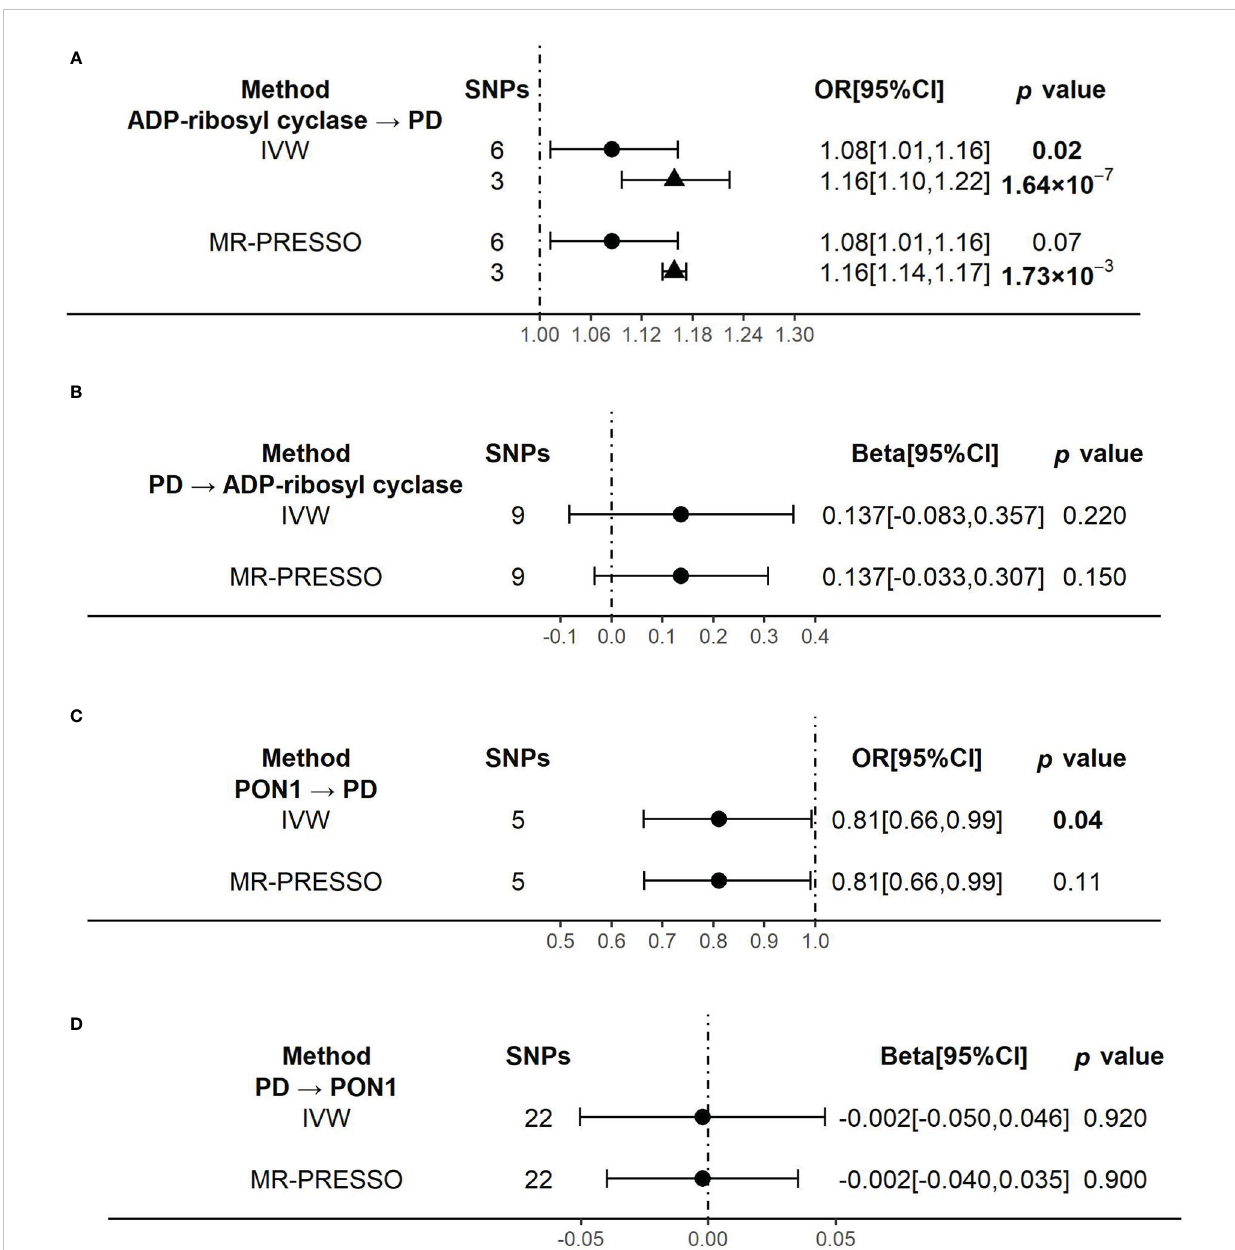
FIGURE 3 The results of the causal effects between ADP-ribosyl cyclase, PON1 and Parkinson ’ s disease by Mendelian Randomization analysis (A) The causal effect of ADP-ribosyl cyclase on PD. (B) The causal effect of PD on ADP-ribosyl cyclase. (C) The causal effect of PON1 on PD. (D) The causal effect of PD on PON1.. 95% con fi dence interval, 95% CI; inverse-variance weighted, IVW; Mendelian randomization-pleiotropy residual sum and outlier, MR-PRESSO; Parkinson ’ s disease, PD. Circulars illustrate the results from primary instrumental variables (IVs) and triangles mean the results from outliers removed